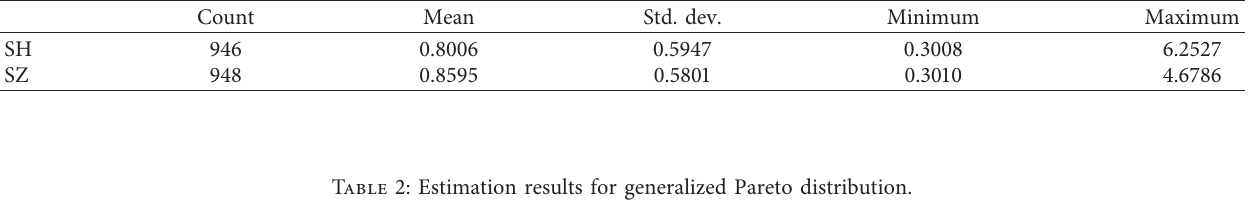
Figure 1: Mean excess functions for the (a) SH composite index and (b) SZ component index. Table 1: Summary statistics of extreme jumps in the SH composite index and SZ component index.